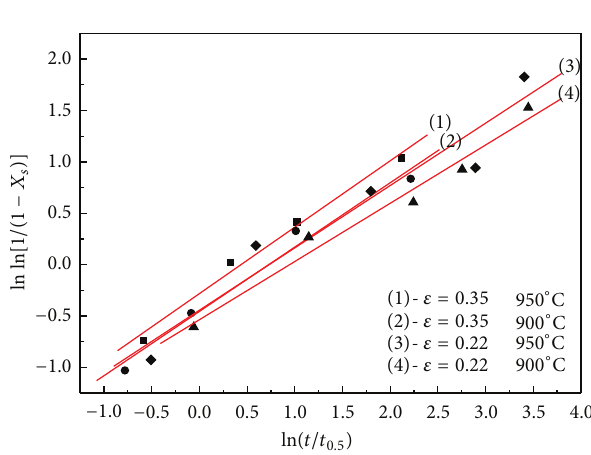
Figure 7: The relation between lnln [1/(1 − 𝑋 𝑠 )] and ln (𝑡/𝑡 0.5 ) .